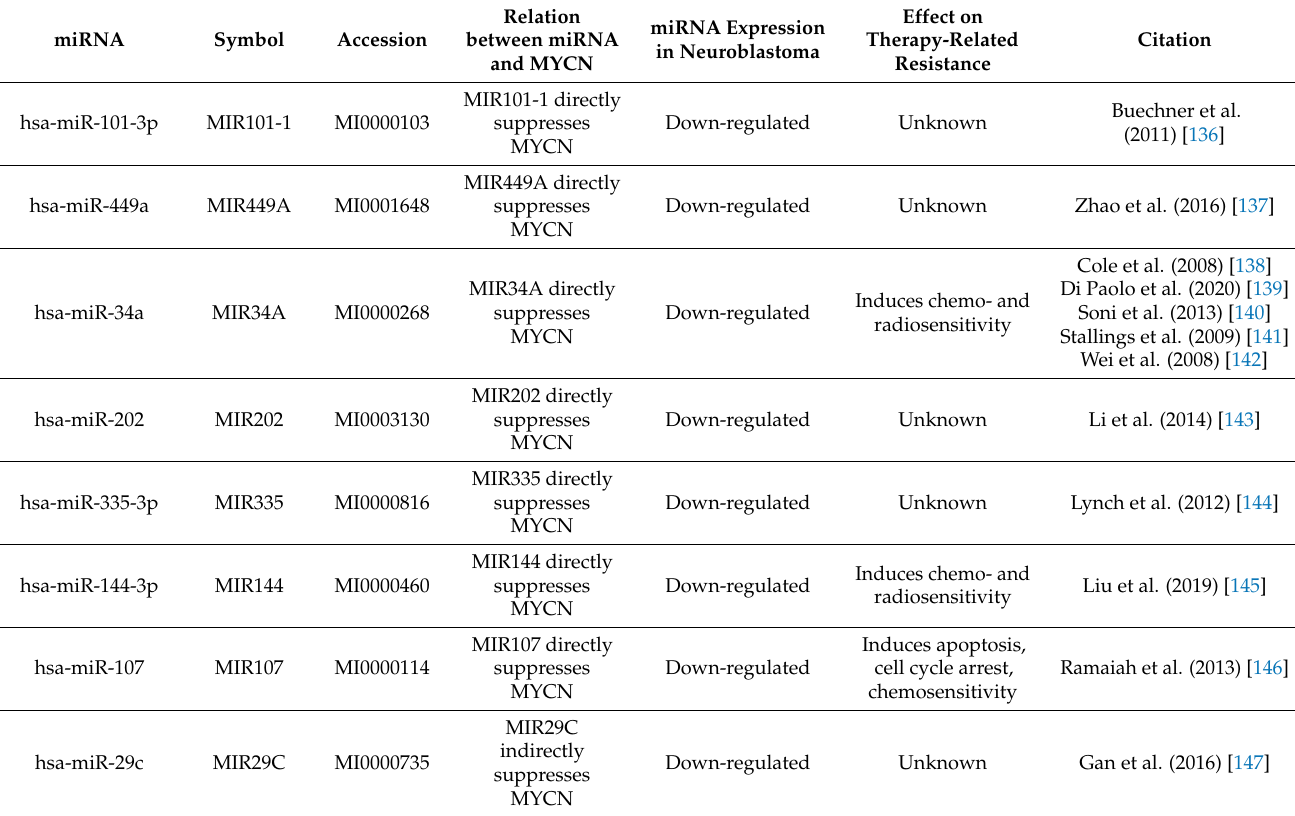
Table 3. MYCN-related miRNAs. Out of 234 miRNAs targeting MYCN, twenty were studied for their role in neuroblastoma. miRNA Symbol Accession